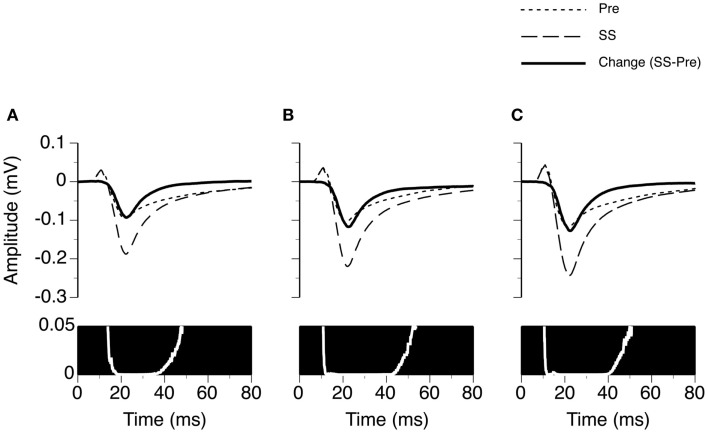
Group results (n = 26) showing the time window over which SS enhances the amplitude of an LFP recorded at the BF of the recording site. (A–C) are based on LFPs recorded at 10, 20, and 30 dB above the MT of a recording site. In the upper panels of (A–C), dotted and dashed lines represent grand-mean waveforms of LFPs recorded before and during SS, respectively. A solid black line is the difference between two grand-mean waveforms. A white line with a black background is a p-value (Wilcoxon signed-rank test) by time function comparing the difference between the amplitudes of the two grand-mean waveforms.